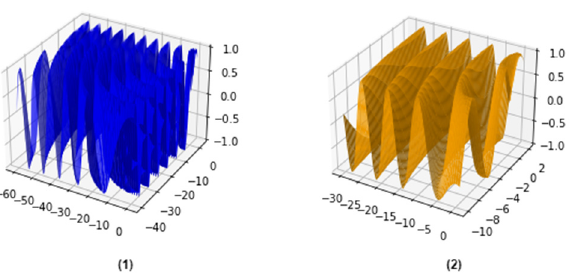
Figure 4. CPU Usage and the Rate of Computational Power Utilization. ( 1 ) The current Hyperledger PoW and ( 2 ) the Proposed Lightweight-BIoV Consensus.